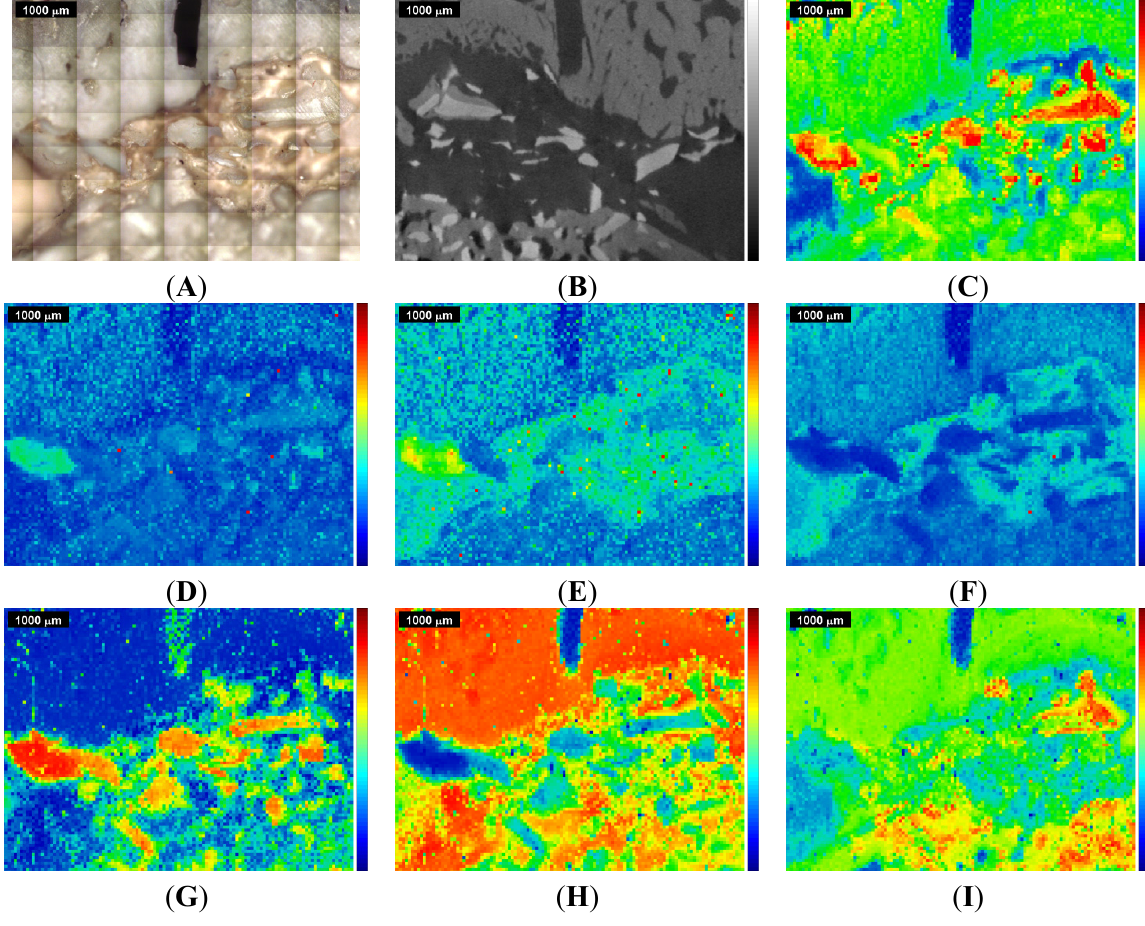
Figure 3. Raman images and correlation maps obtained within ROI 2 from the second measurement of the sinus grafted bone sample (see also Supplementary Materials). Red means high intensity or high correlation, blue means low intensity or low correlation. Upper row: ( A ) microscopic image; ( B ) µ-CT image; ( C ) Raman image centered at the ν 1 PO 43 − peak at 961 cm − 1 . Mid row: Raman images centered at ( D ) the B-type carbonate substitution peak at 1075 cm − 1 ; ( E ) the amide I peak at 1677cm − 1 ; ( F ) the CH stretching peak at 2937 cm − 1 . Lower row: correlation of the individual spectra of the Raman map with the ( G ) Bio-Oss ® Raman spectrum; ( H ) natural pork bone Raman spectrum; ( I ) tricalcium phosphate Raman